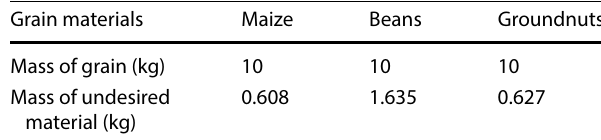
Table 1 Proportions of gain and undesired material used in perfor- mance evaluation Grain